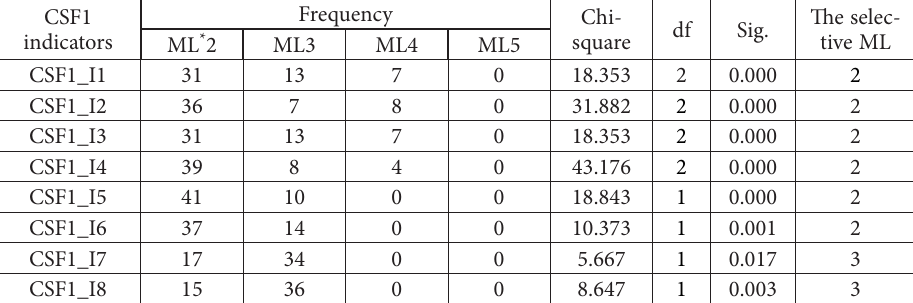
Table 4. Results of chi- square test for classifying the indicators of “strategy” critical success factor between maturity levels CSF1 indicators